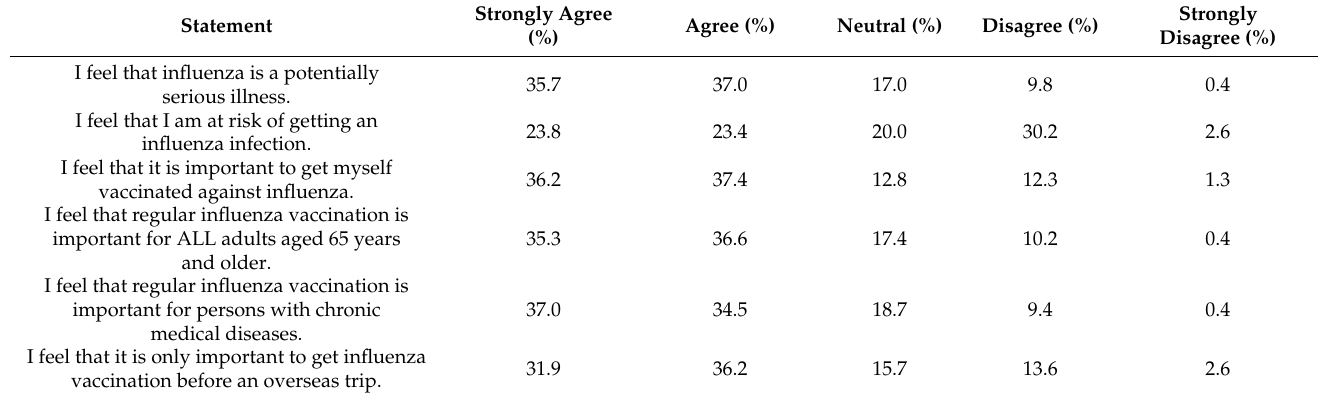
Table 3. Attitudes towards influenza infections and vaccinations (N =